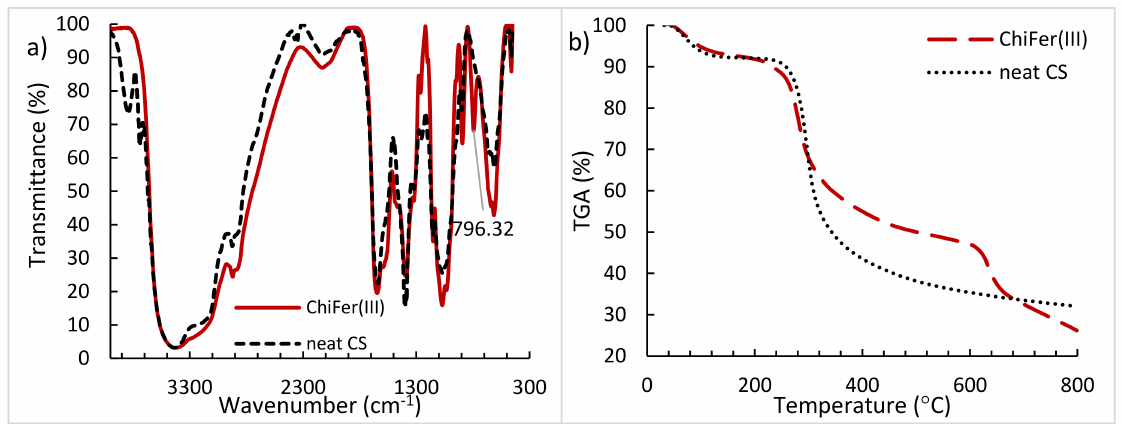
Figure 2. ( a ) FTIR and ( b ) TGA curves of neat CS and